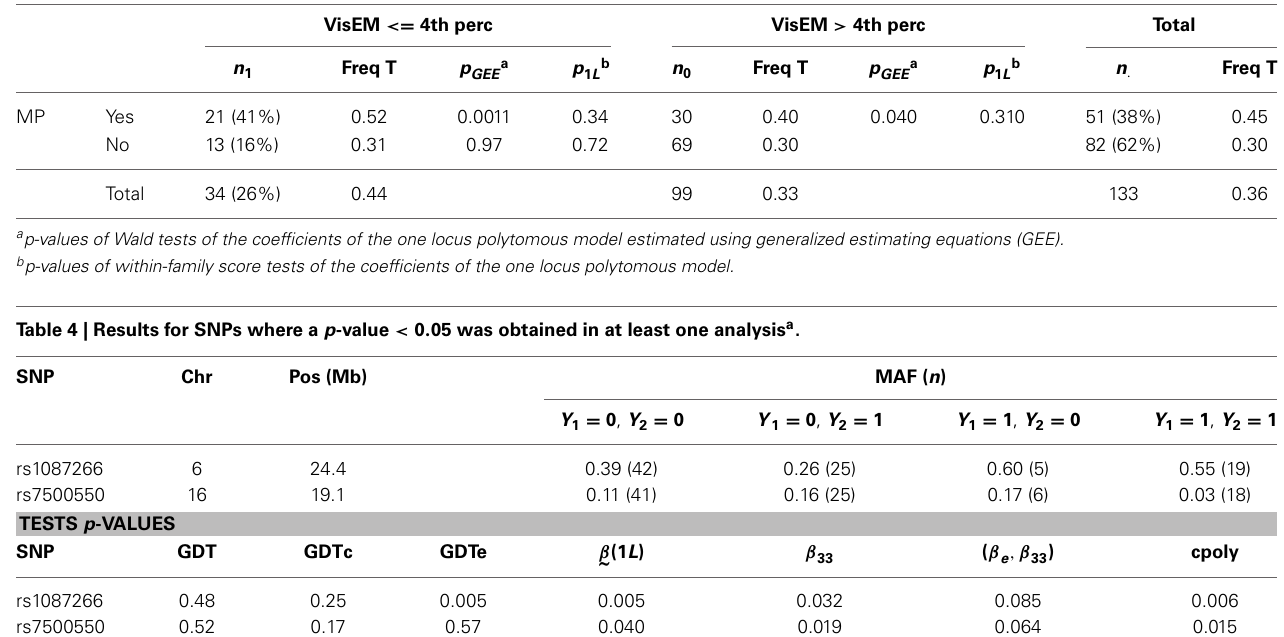
Table 3 | Joint distribution of major psychosis and visual episodic memory deficits along with the frequency of the rs1156026 T allele.